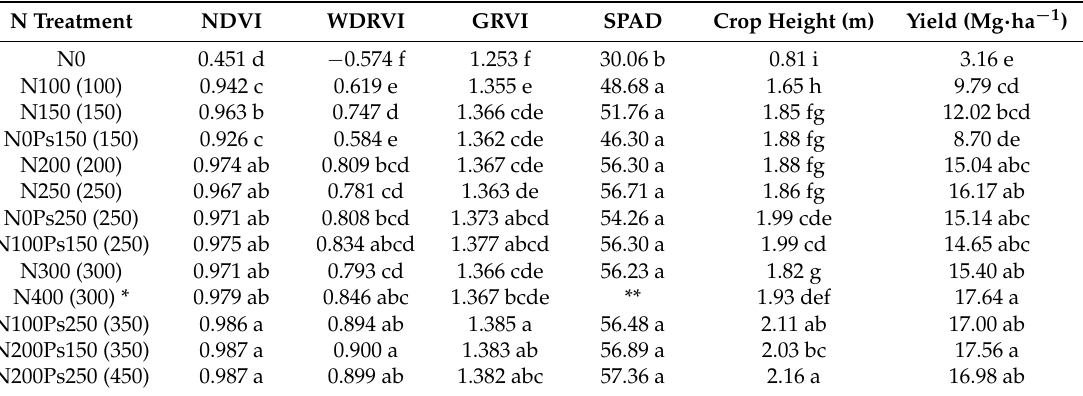
Table 1. Mean values of the vegetation indices and crop height (n = 50 for each treatment replication), SPAD (n = 15 for each treatment replication) and yield (n = 4) for the different nitrogen (N) treatments applied on the experimental plots. Tukey’s HSD test: different letters indicate homogeneous groups with respect to the mean differences at a p -value of <0.05. The total amount of N (kg · ha − 1 ) applied up to vegetation stage V12 is given in